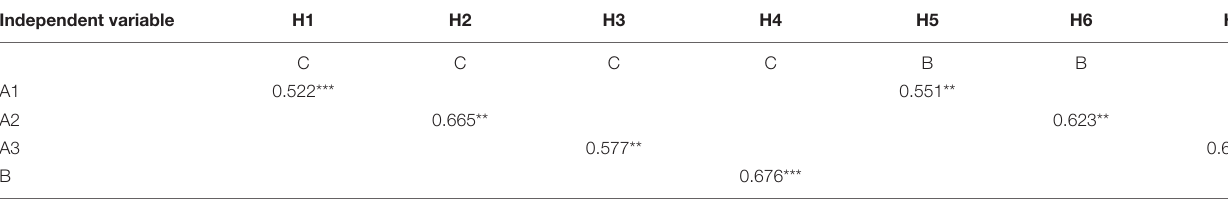
TABLE 5 | Results of linear regression analysis. Independent variable